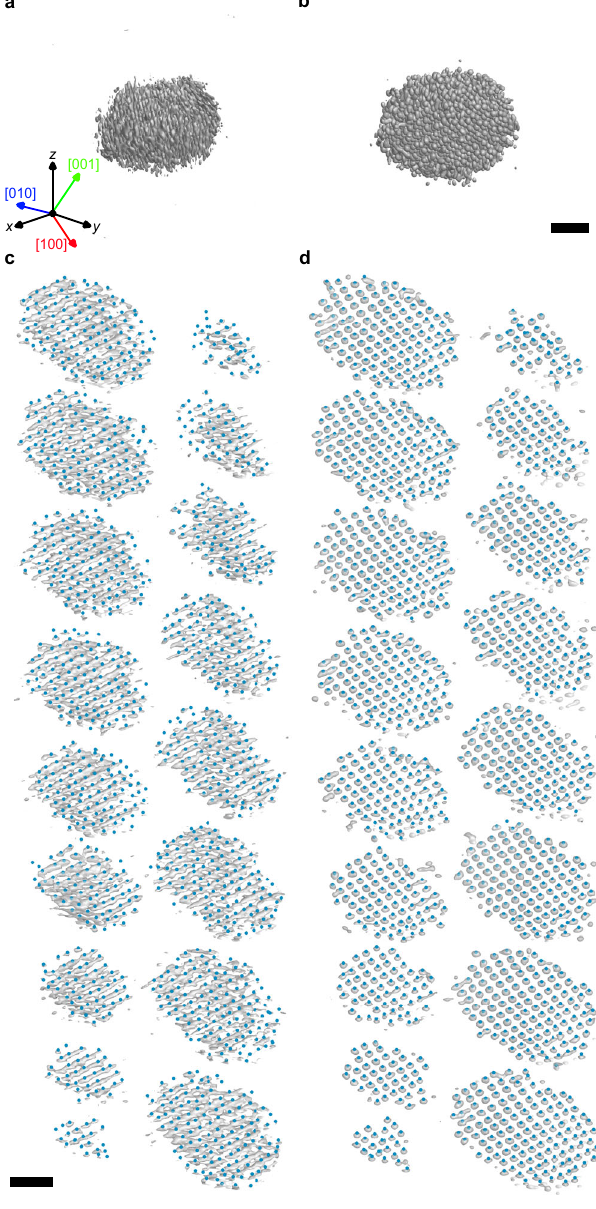
Fig. 3 The 3D density maps of the experimentally measured Pt nanoparticle tomograms and traced atomic coordinates. a , b Iso-surfaces of reconstructed 3D density are plotted with 40% and 15% iso-surface values from the maximum intensity for tomograms before ( a ) and after ( b ) the DL augmentation, respectively. The z direction is the missing wedge direction. c , d Reconstruction volume intensity and traced atom positions. Each slice represents an atomic layer, and the blue dots indicate the traced 3D atomic positions before ( c ) and after ( d ) the DL augmentation. The grayscale backgrounds of the atomic positions are iso-surfaces of 3D density with 40% ( c ) and 15% ( d ) iso-surface values from the maximum intensity. The sliced layers are perpendicular to [001] direction. Here the DL augmentation network trained by the f.c.c.-based atomic model with Bfactor 5 Å 2 was used. Scale bars, 1